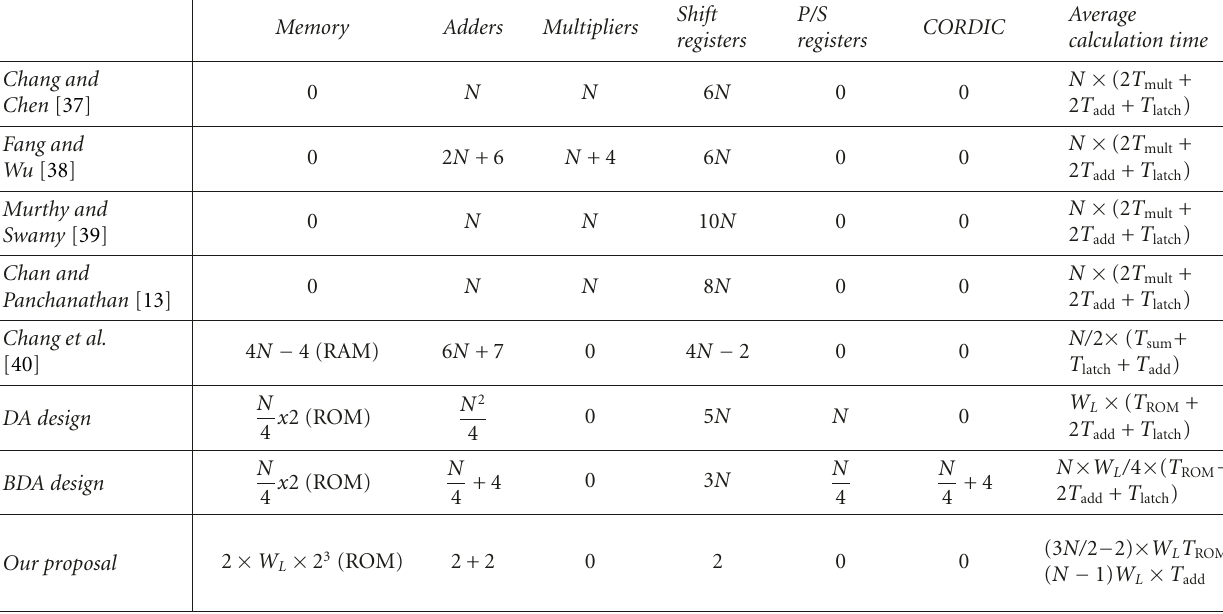
Table 11: Comparison between our proposal and other ones.